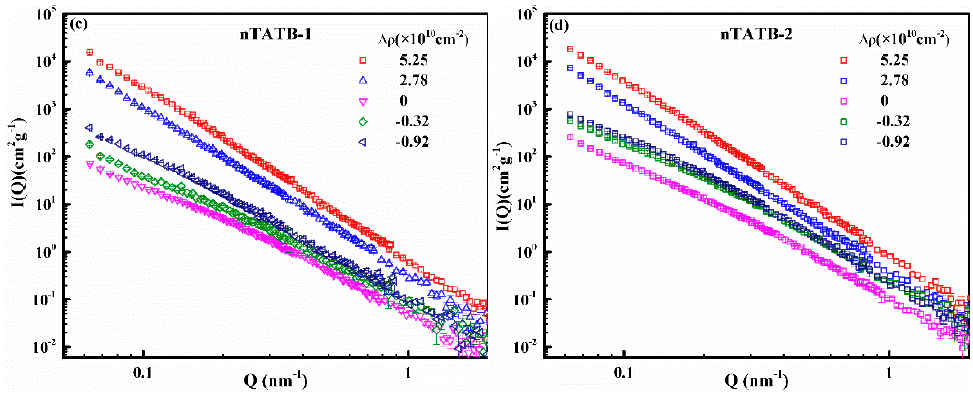
Figure 2. Scattering curves as a function of contrast for both micro-sized ( a , b ) and nano-sized ( c , d ) samples. Significant changes both in intensity and shape of curves are obvious for the two nano-sized samples.